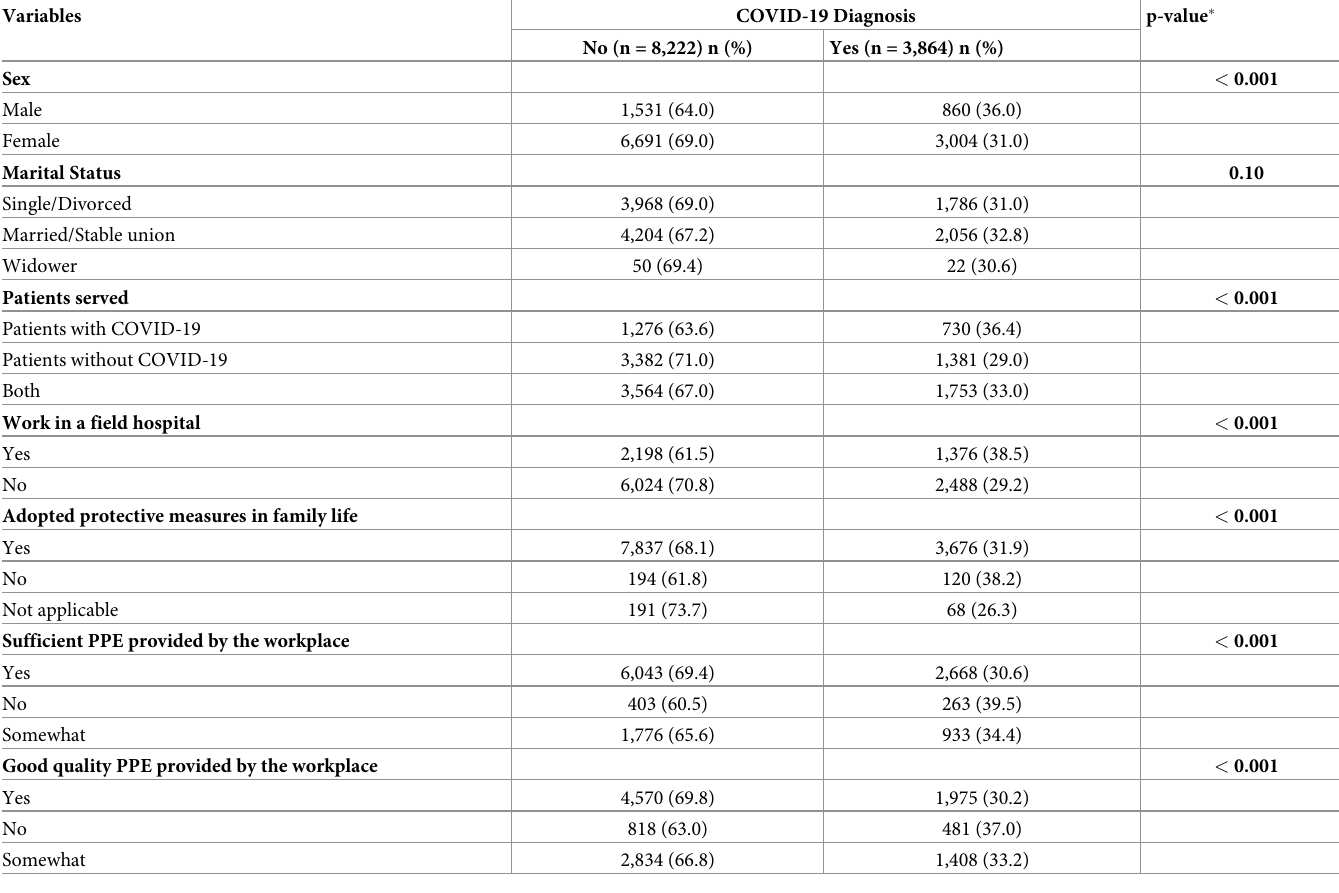
Table 2. Bivariate analysis of potential factors associated with the diagnosis of COVID-19 among health professionals, Brazil, 2020 (N = 12,086). Variables COVID-19 Diagnosis p-value � No (n = 8,222) n